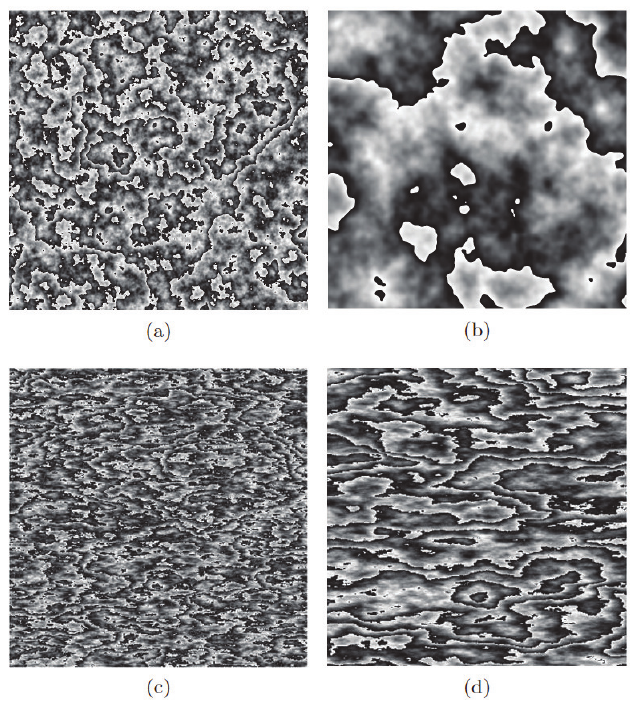
Figure 11. Turbulent phase screens of non-classic turbulence with 2 π wrapped phase for application on SLM/DMD. Vertical turbulence with α = 3.2 ( a ) µ z = 1, ( b ) µ z = 5. Horizontal turbulence with µ x = 3, µ y = 1, ( c ) α = 3.2, ( d ) α = 3.67. Reprinted with permission from References